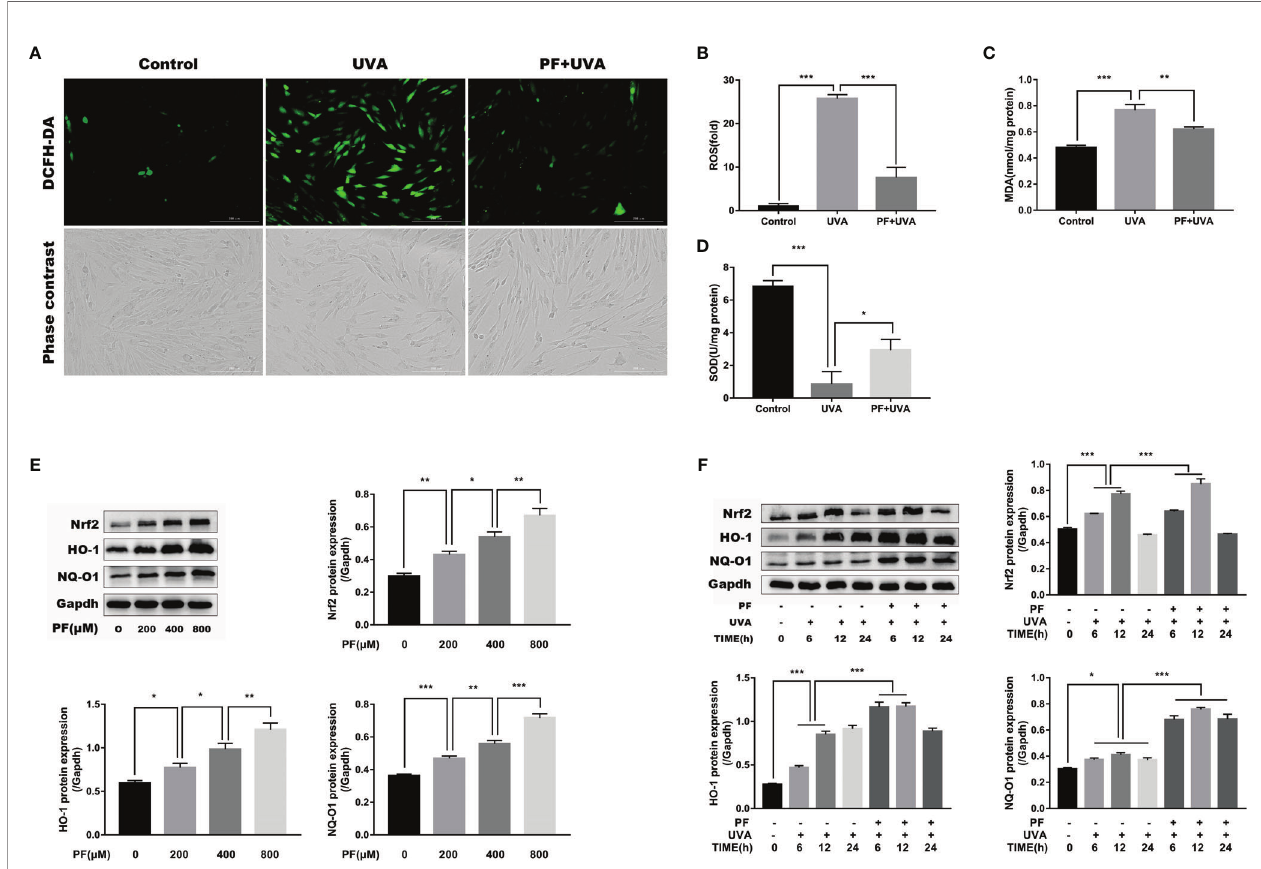
FIGURE 2 | PF inhibited UVA-induced oxidative stress in HDFs. (A) The levels of ROS were indicated by DCF fl uorescence emitting green fl uorescent under fl uorescence microscope. (B) The DCF fl uorescence intensity was quanti fi ed by Image-Pro Plus 6.0. and the intensity of DCF fl uorescence in each group was normalized to the control group. Detection of the generation of MDA (C) and the activity of SOD (D) in each group. (E) Western blot showing the protein levels of Nrf2, HO-1, and NQ-O1 in fi broblasts treated with PF (0, 200, 400, and 800 m M), the representative result of western blot and the quantitative analyses of three independent experiments were shown. (F) The effects of UVA and PF pre-treatment +UVA on the protein expressions of Nrf2, HO-1, and NQ-O1 at time points of 6, 12, and 24 h, the representative result of western blot and the quantitative analyses of three independent experiments. All data were expressed as the mean ± SD according to at least three independent experiments. * p < 0.05, ** p < 0.01, *** p <